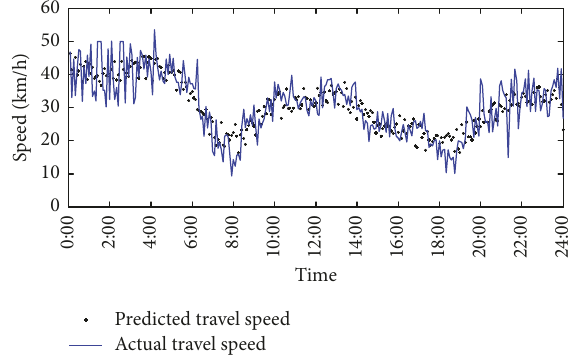
Figure 7: The predicted travel speed curve in December 1,